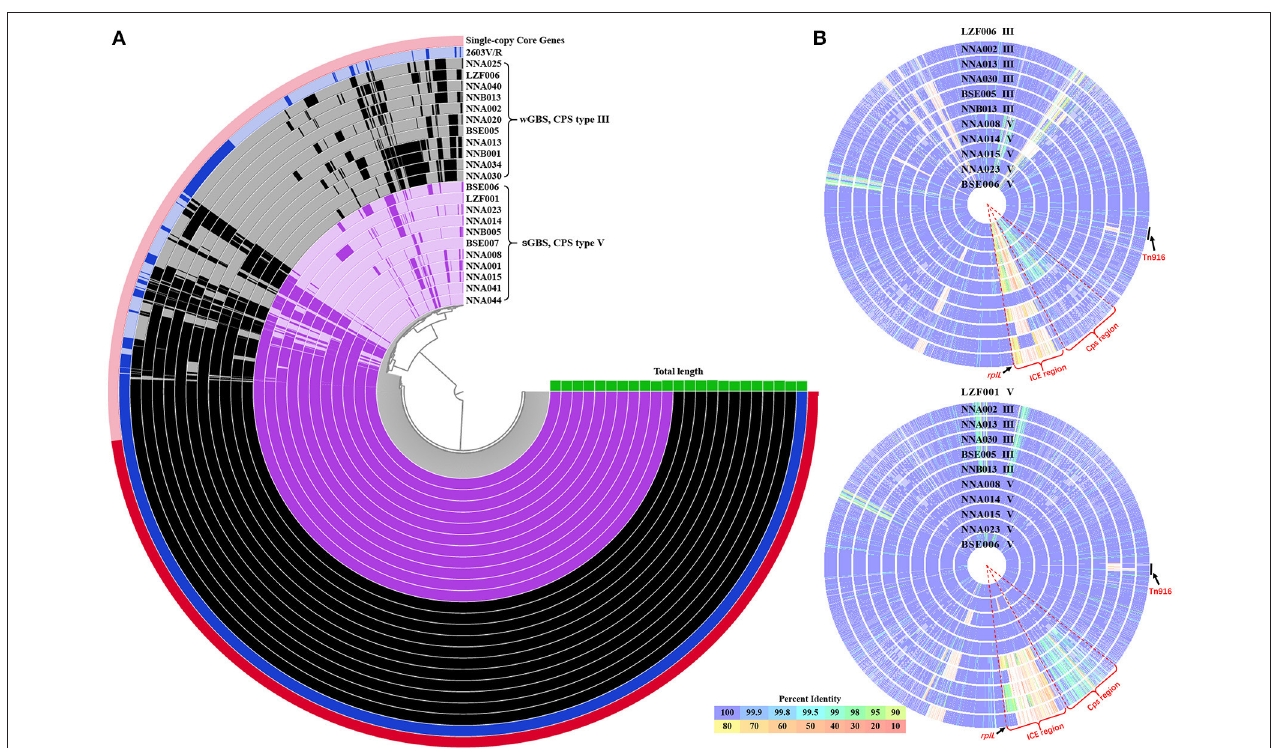
FIGURE 1 | The pan-genome and comparison of sGBS and wGBS genomes. (A) Anvi’o pangenome visualization of sGBS and wGBS genomes. The red part in outer ring showed single-copy core genes. The genomes of sGBS and wGBS were shown in purple and black, respectively, and the 2603V/R genome was shown in blue, the green histogram meaned genome length. (B) Comparison of genomes of sGBS and wGBS. The LZF006 (wGBS) genome and the LZF001 (sGBS) genome were served as the reference, respectively, and other genomes were aligned to the reference genome; each circle represented a different genome, the strain name and CPS type were labeled on each circle. The circle of reference genome was not shown; the color bar on the bottom indicated the percentage of protein sequence identity against the reference genome. The relevant areas and locus were indicated by black arrows in the